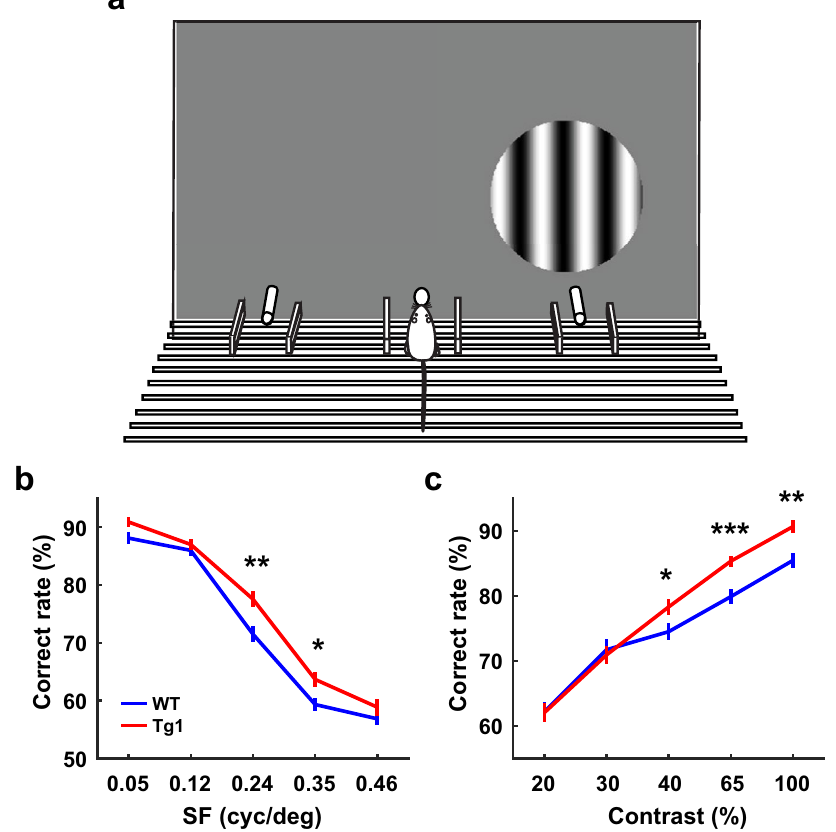
Figure 8. Comparison of behavioural performance between WT and Tg1 mice. ( a ) Schematic illustration of the behavioural apparatus. ( b ) Behavioral performance in visual detection of stimuli that varied in SF (WT mice: n = 8, Tg1 mice: n = 4; P = 0.009, two-way ANOVA, main effect of genotype). ( c ) Behavioral performance in visual detection of stimuli that varied in contrast (WT mice: n = 7, Tg1 mice: n = 6; P = 0.03, two-way ANOVA, main effect of genotype). Error bars, ± s.e.m., * P < 0.05, ** P < 0.01, *** P < 0.001. For performance at each SF or each contrast, P value was obtained from two-way ANOVA followed by Tukey’s multiple comparison